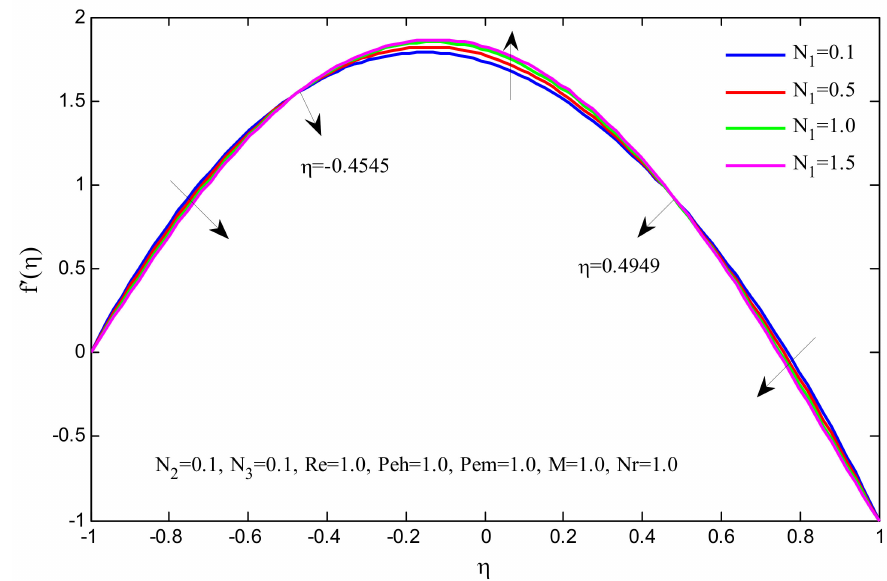
Figure 2. Effect of N 1 on simulated velocity.